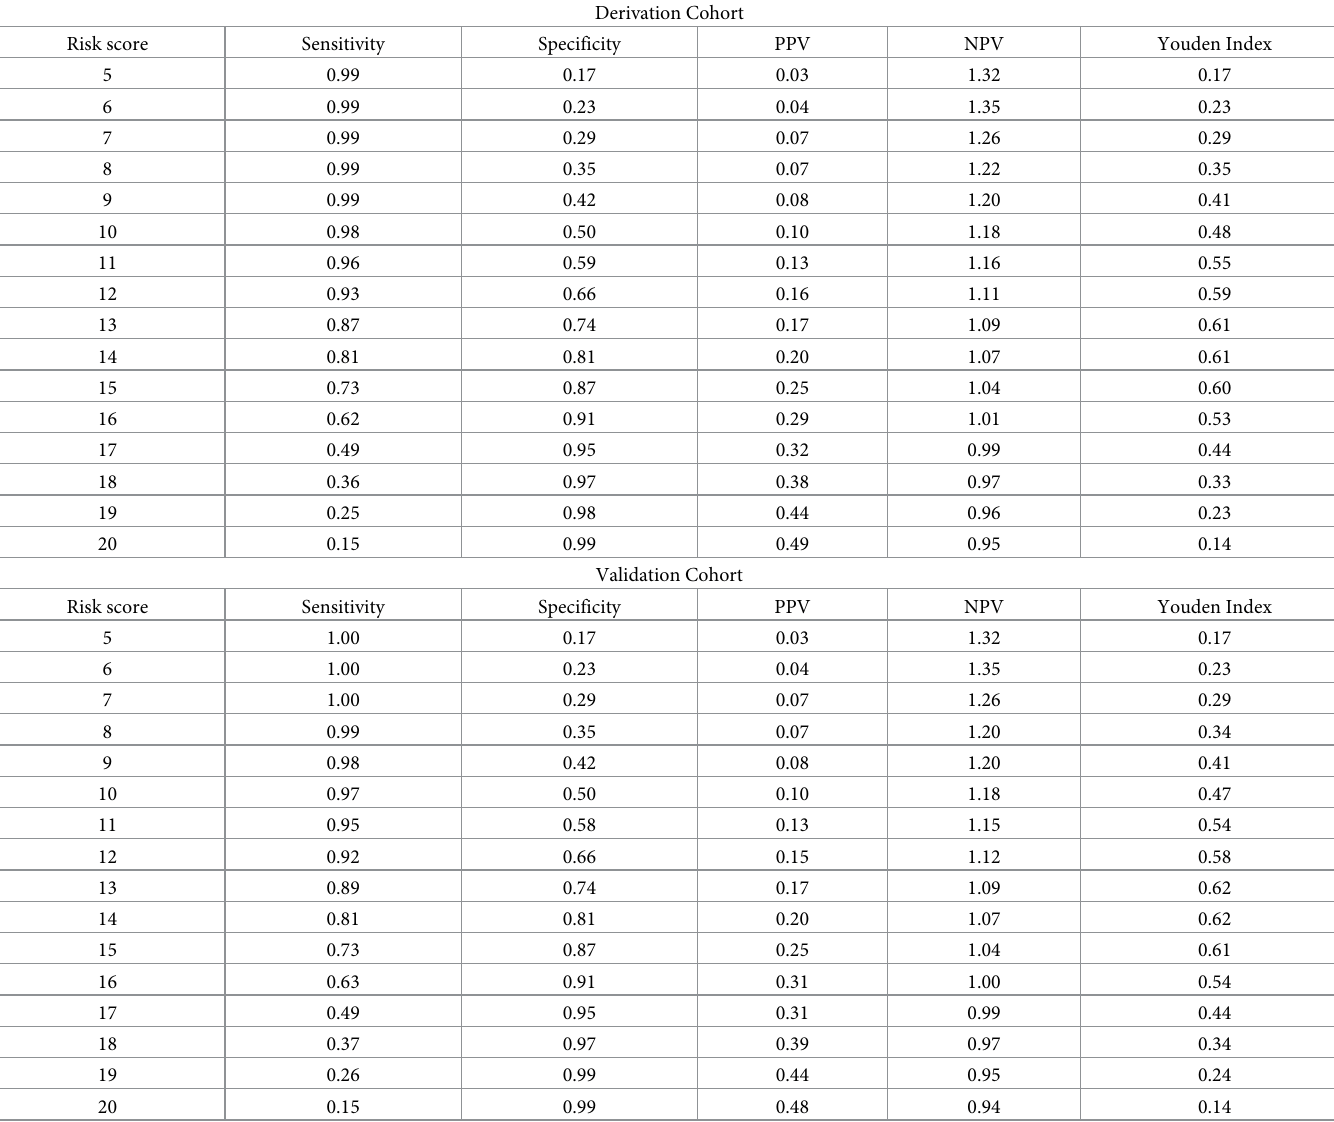
Table 4. Predictive performance of the primary risk score for 5-year metabolic syndrome incidence in derivation and validation